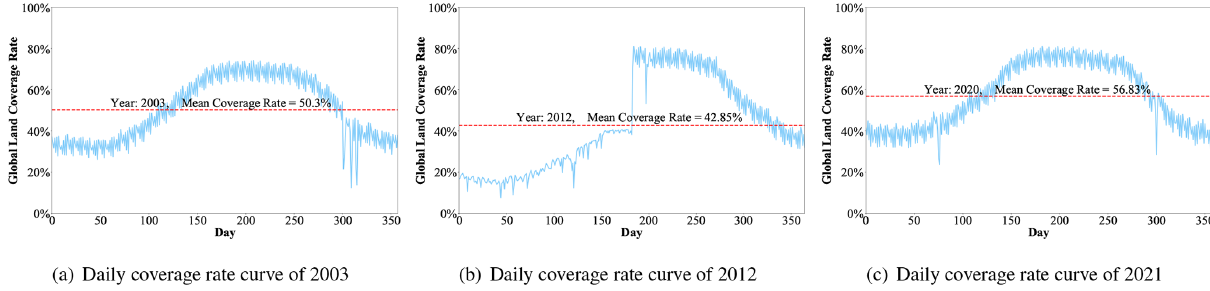
Figure 2. Daily coverage rate curves of AMSR-E, WindSat and AMSR2 soil moisture products in 2002, 2012, and 2021, respectively.